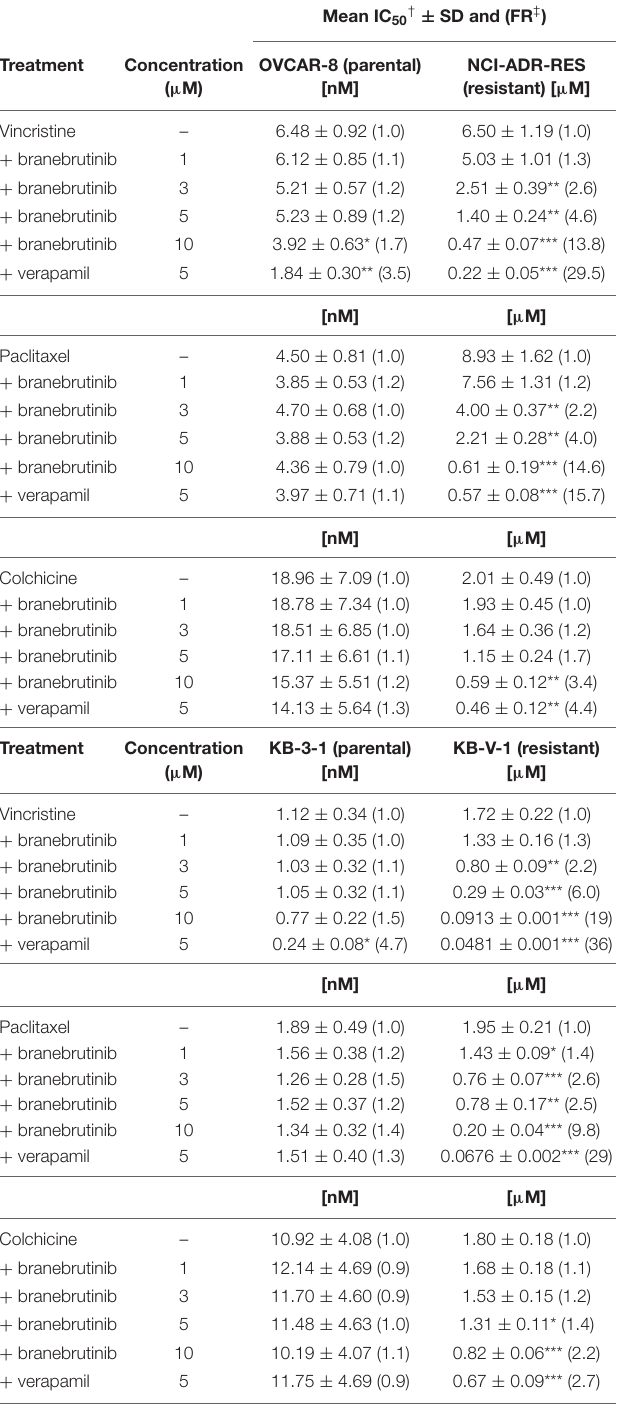
TABLE 1 | Chemosensitizing effect of branebrutinib on drug-selected P-glycoprotein (P-gp)-overexpressing human cancer cell lines. Mean IC 50 † ± SD and (FR ‡